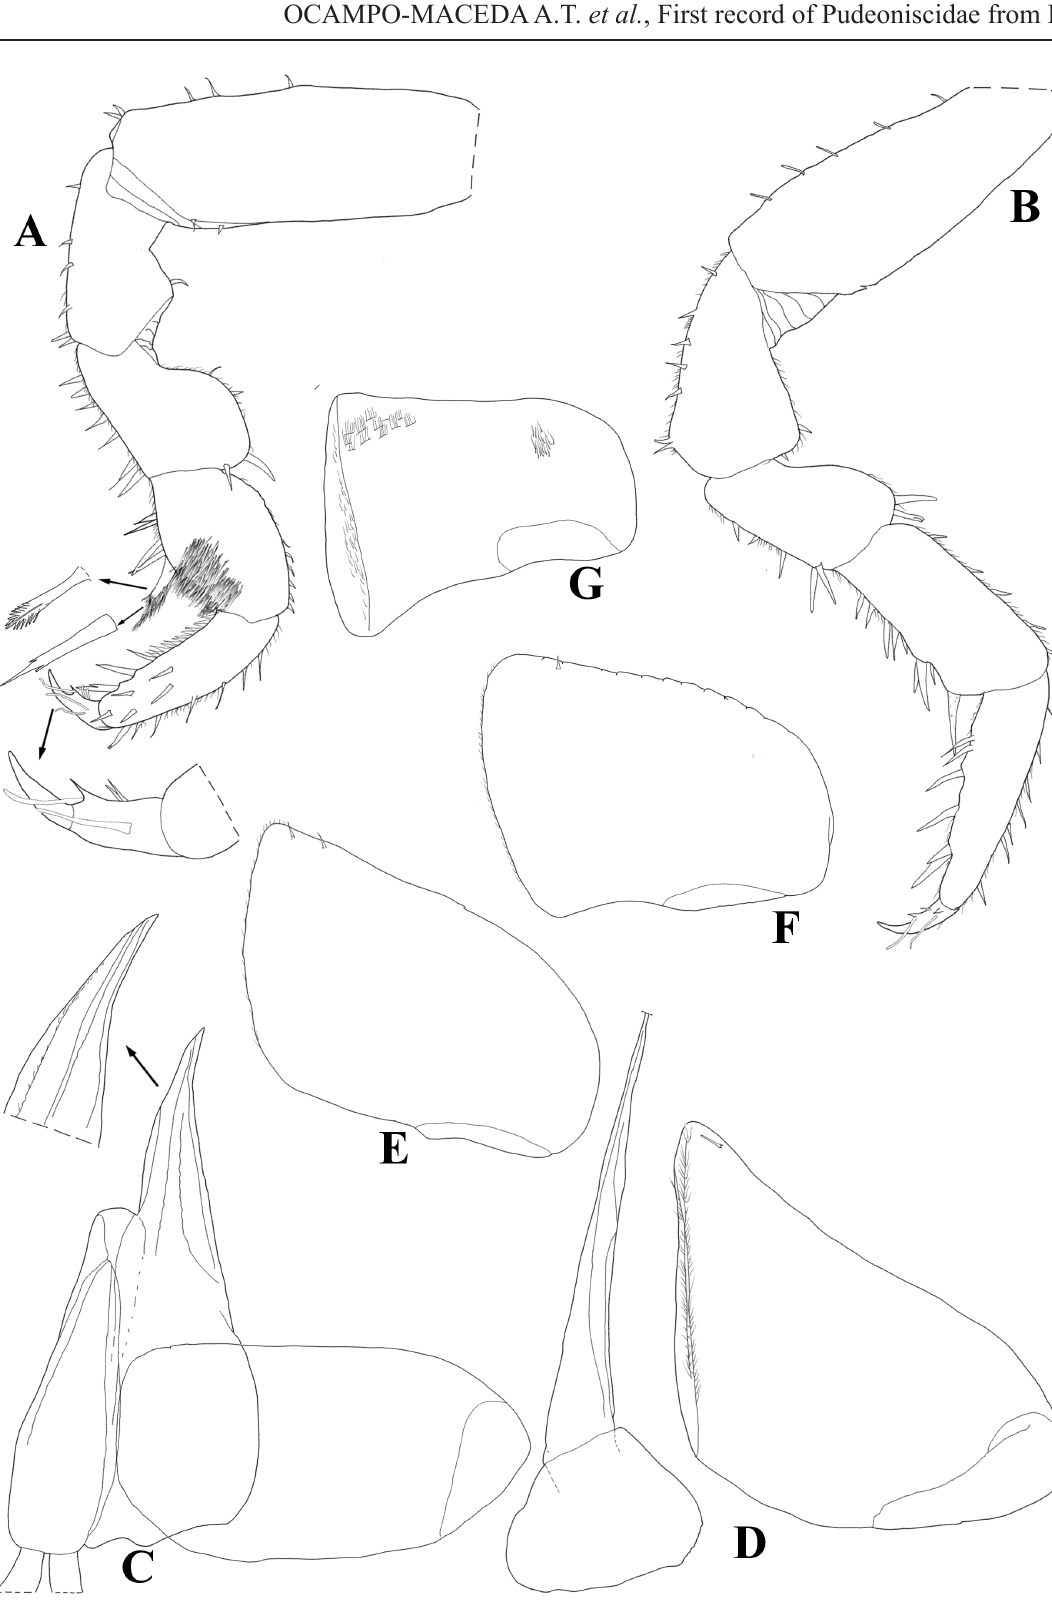
Fig. 3. Loretoniscus mashiriaensis gen. et sp. nov., holotype, ♂ (MUSA-ENT-ISO 025). A . Pereopod 1; B . Pereopod 7. C . Genital papilla and pleopod 1. D . Pleopod 2. E . Pleopod 3 exopod. F . Pleopod 4 exopod. G . Pleopod 5